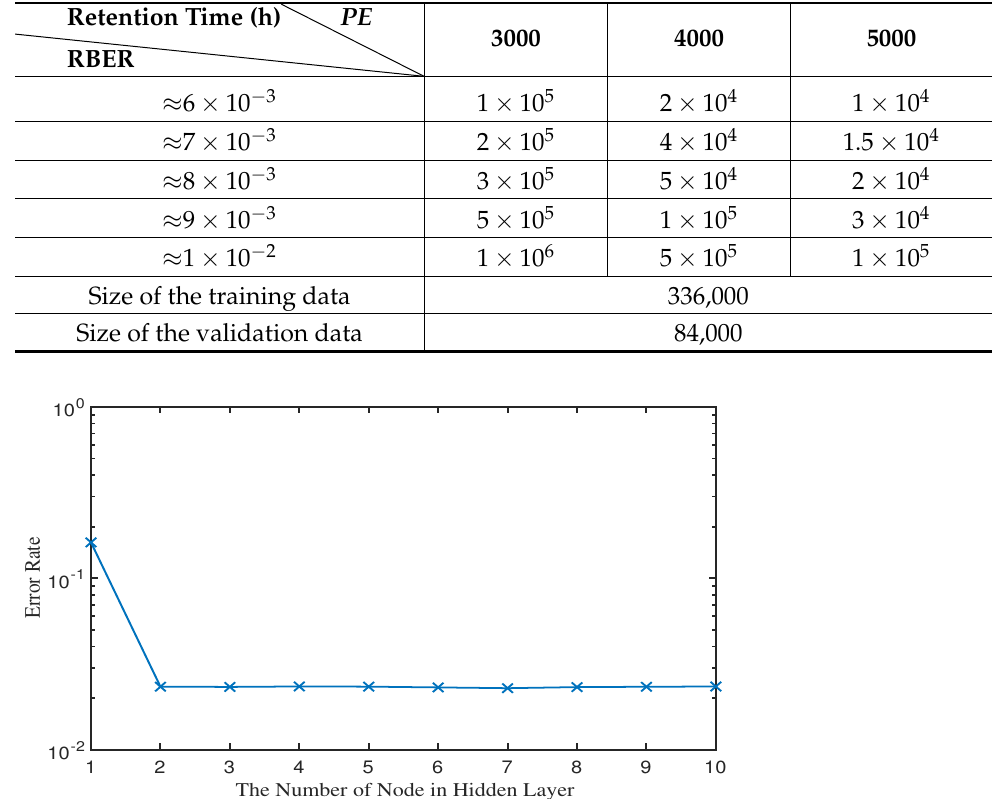
Table 2. Training dataset ( s = 1).